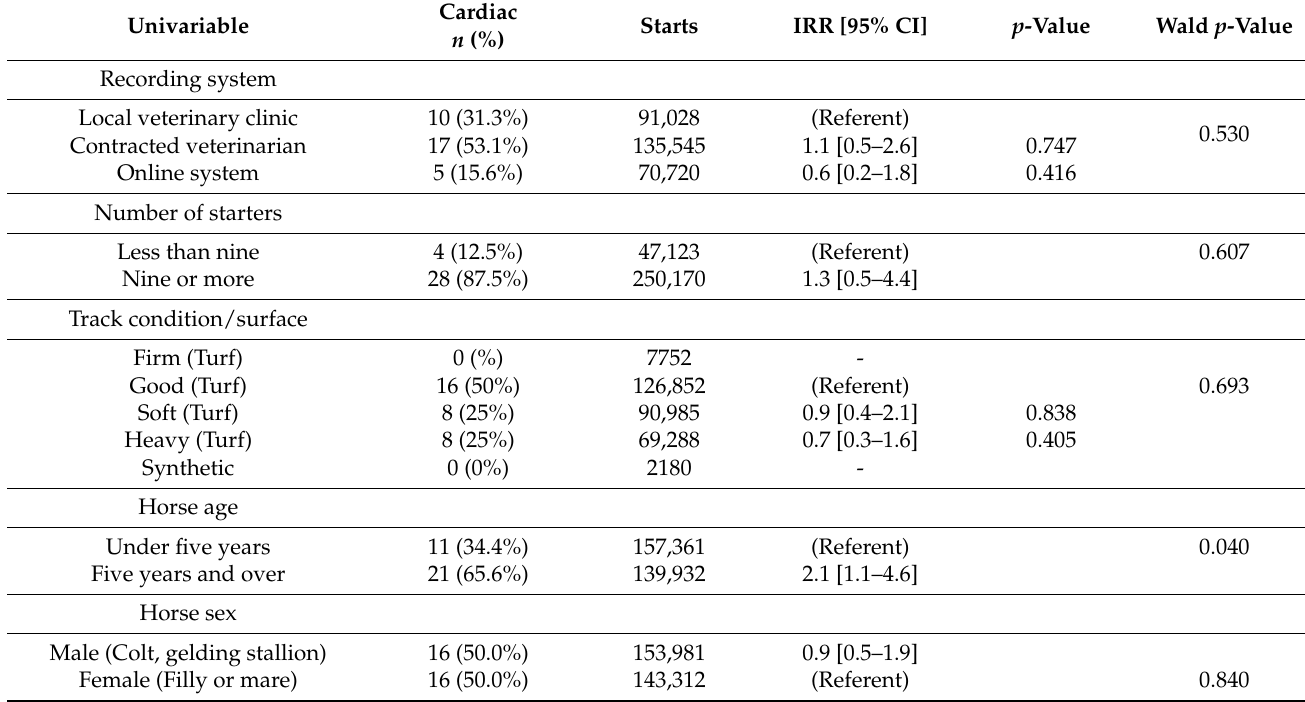
Table 2. Univariable incidence rate ratios (IRR) and 95% confidence of a suspected cardiac failure occurring with the effects of the recording system, number of participants, track surface, horse age, horse sex and race distance for Thoroughbred flat racing in the 2011/12–2021/22